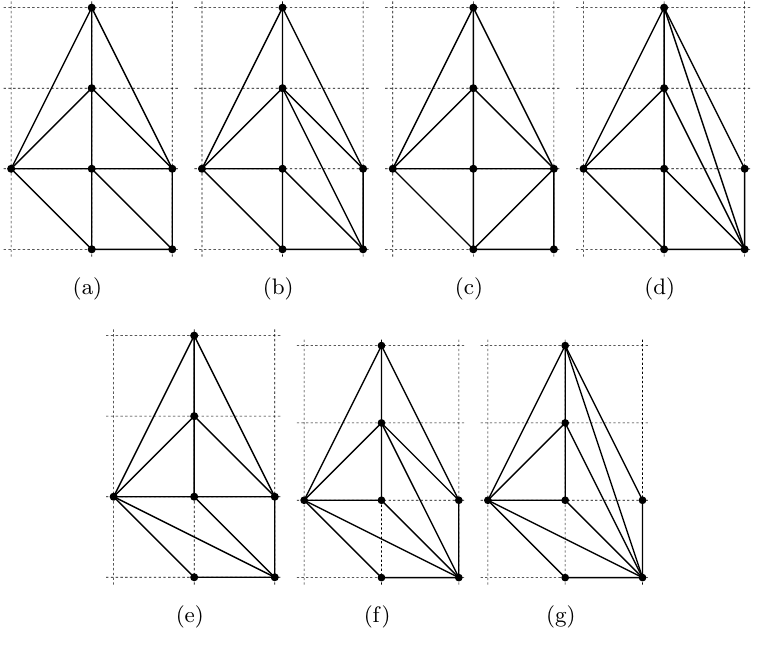
Figure 11 . The 7 crepant singularities of the E 22 ; 3 2 singularity. The (cid:12)rst four, (a)-(d) admit a vertical reduction, corresponding to chambers of the SU(3) 3